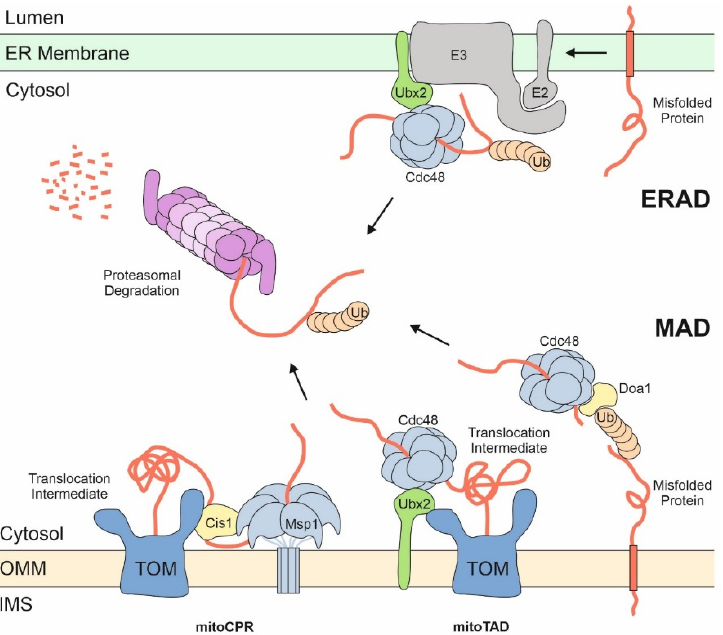
Figure 3. Proteasomal degradation of proteins at the ER and the mitochondrial surface. ER and mitochondrial proteins are released by the AAA proteins Cdc48/p97 (on both ER and mitochondria) or Msp1 (on mitochondria) into the cytosol to be degraded by the proteasome. Poly-ubiquitin chains serve as degradation signals and as handles on the proteins for unfolding and insertion into the proteasome. Adaptor proteins such as Ubx2 or Doa1 play crucial role in the substrate binding of AAA proteins. Stalled translocation intermediates induce the recruitment of Msp1 to the TOM complex by Cis1 in a process called mitochondrial compromised protein import response (mitoCPR). MAD of translocation intermediates is also referred to as mitochondrial protein translocation-associated degradation (mitoTAD).